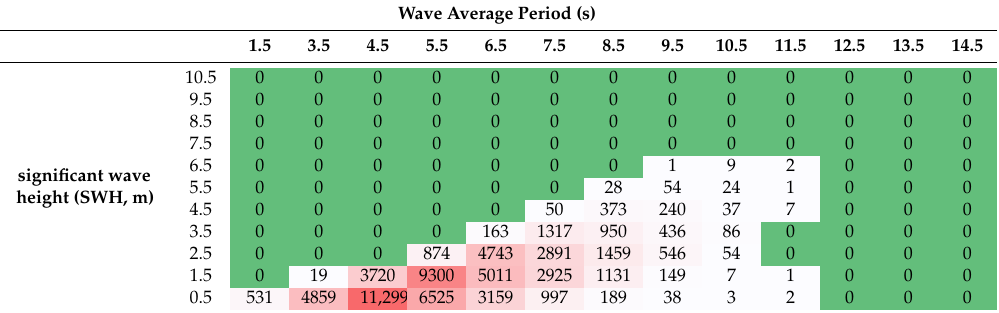
Table 1. Joint probability distribution of significant wave height (SWH) and wave average period ( T av